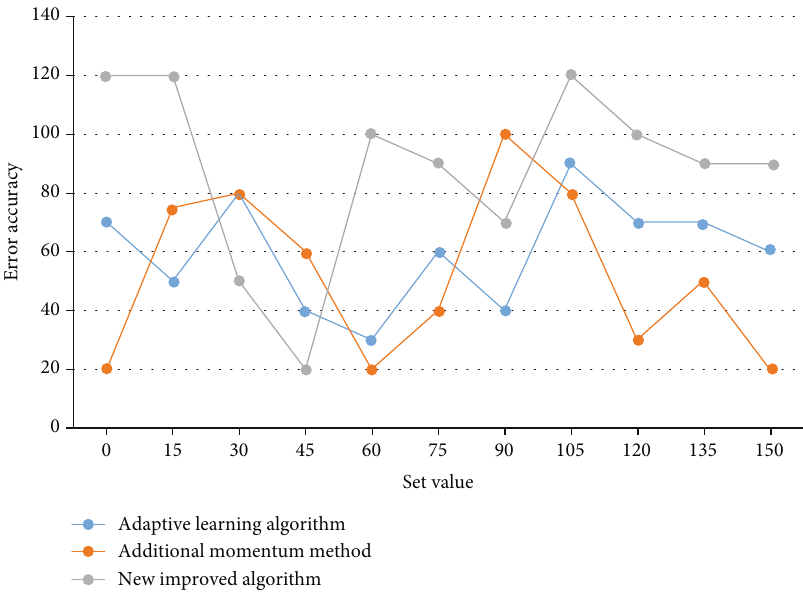
Figure 7: Error curves of new improved algorithm, additional momentum method, and adaptive learning rate algorithm.